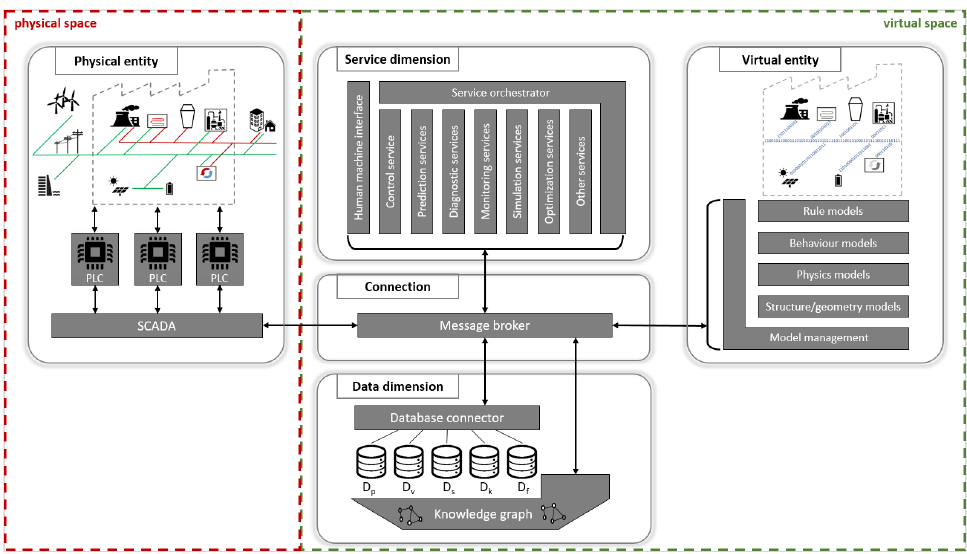
Figure 2. Illustration of the DT platform for an IES inspired by the five-dimensional 5D-DT concept and the